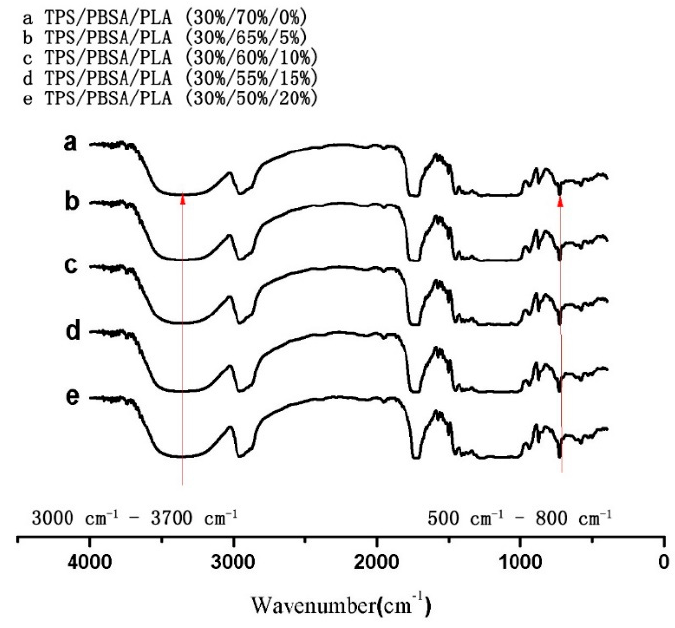
Figure 8. FTIR spectra of the TPS/PBSA/PLA composites.